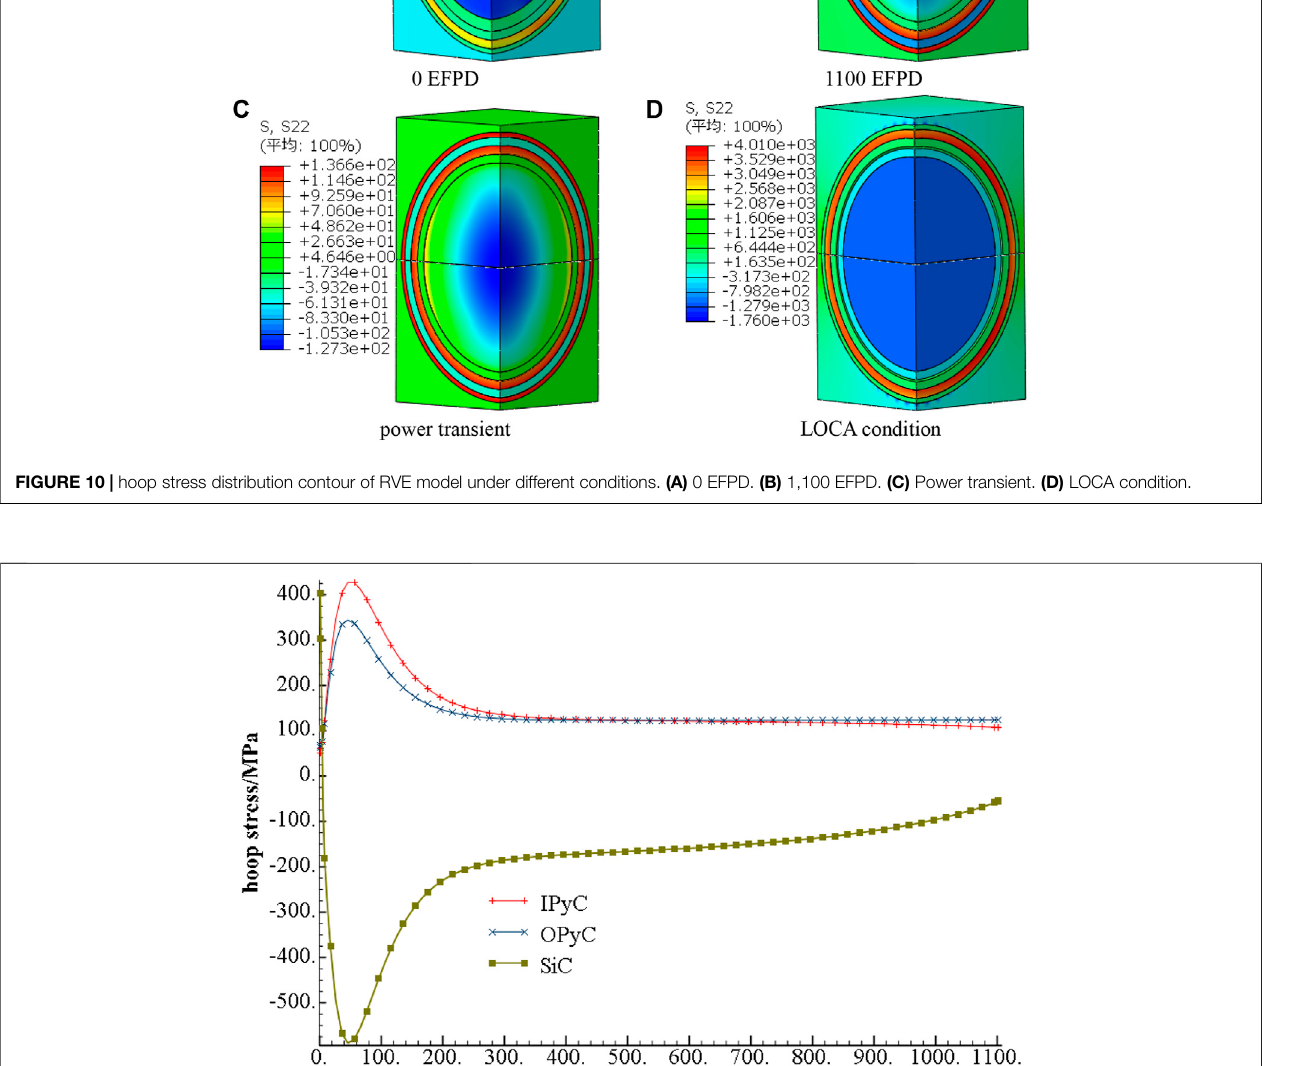
Frontiers in Energy Research |